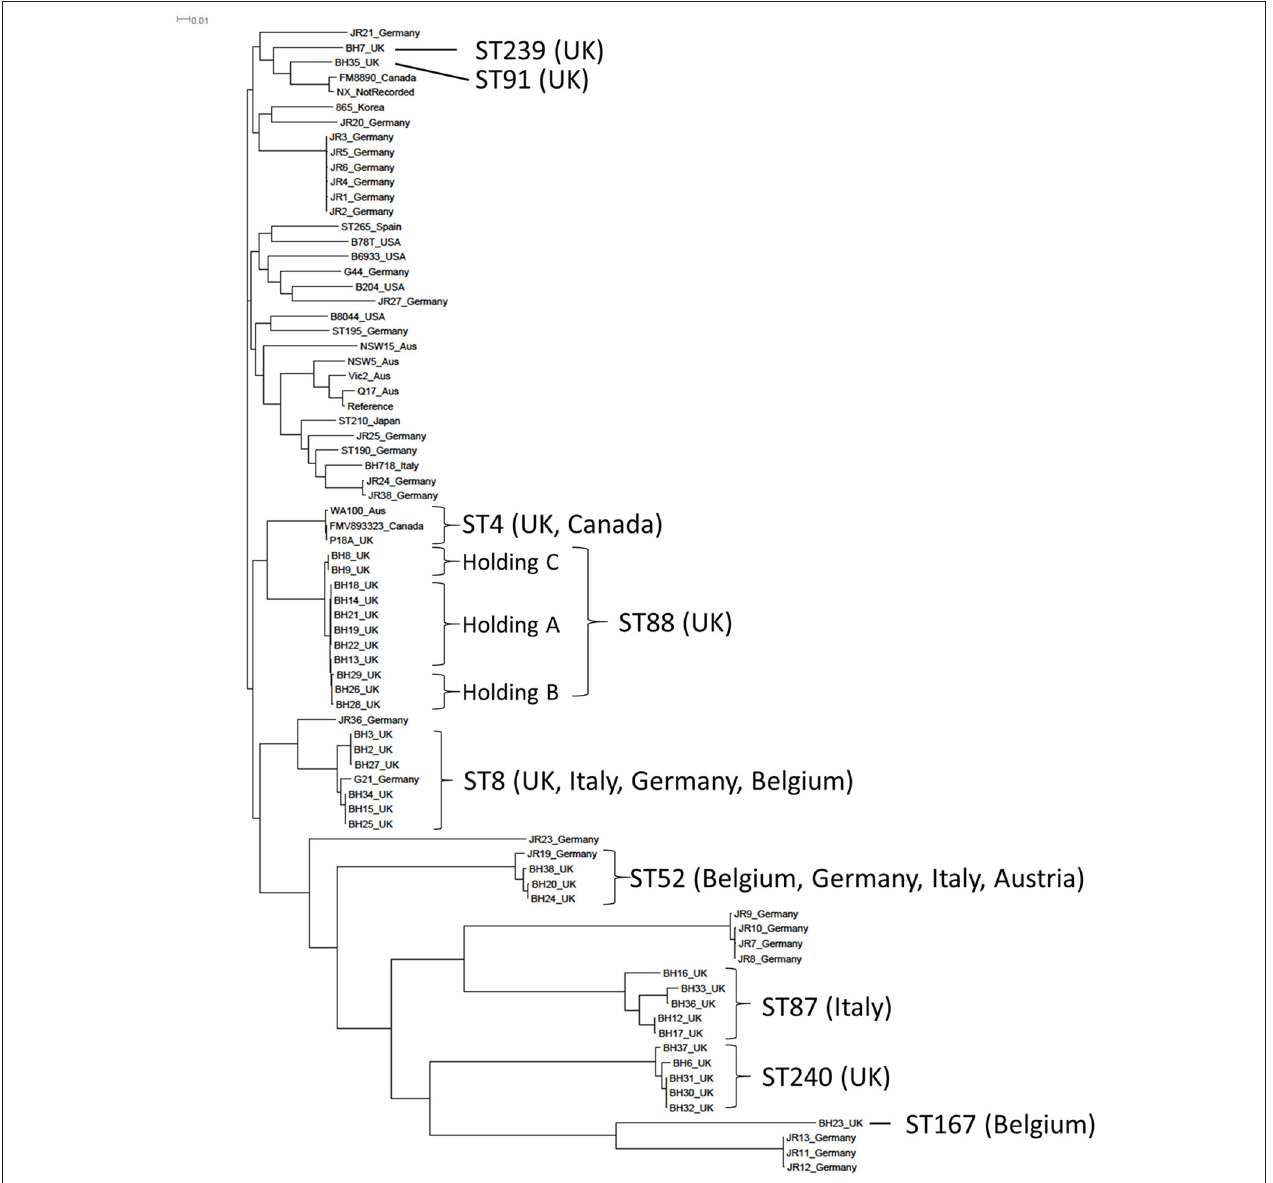
FIGURE 1 | A phylogenetic construction of Brachyspira hyodysenteriae isolates using a maximum-likelihood tree. The 34 field isolates sequenced in this project have been included together with 43 published B. hyodysenteriae genomes. The Sequence Type (ST) of the 34 isolates sequenced in this study together with countries in which these STs have been described previously is